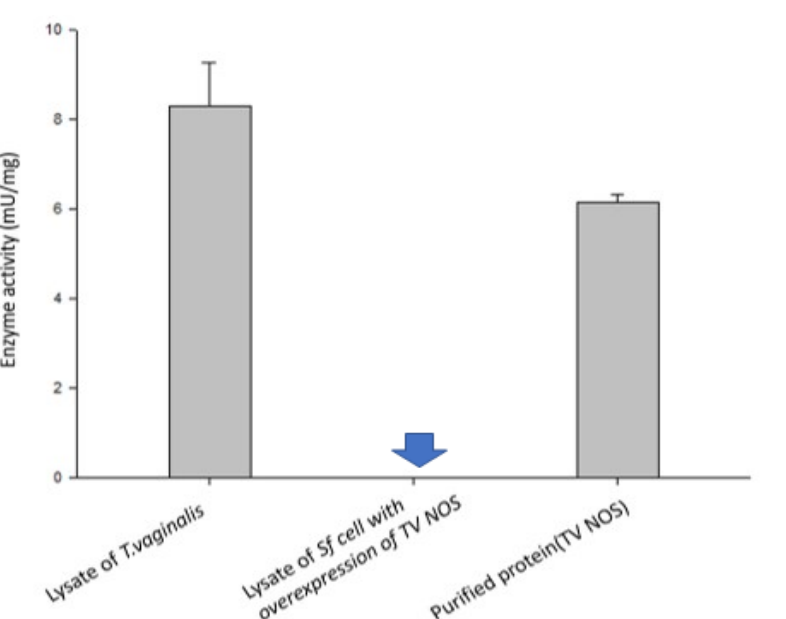
Figure 9. Analysis of NOS activities in crude lysate from TV cells, in crude lysate from Sf insect cells exogenously overexpressing TV NOS and with purified TV NOS proteins. Note that activity of TV NOS (blue arrow, mean = 0.009, SD: 0.002) was greatly suppressed in Sf cells as compared to TV cells (mean = 8.2970, SD: 0.966) and purified TV NOS proteins (mean = 6.160, SD: 0.176), suggesting that certain NOS inhibitor exists in insect cells which can block NOS activity.